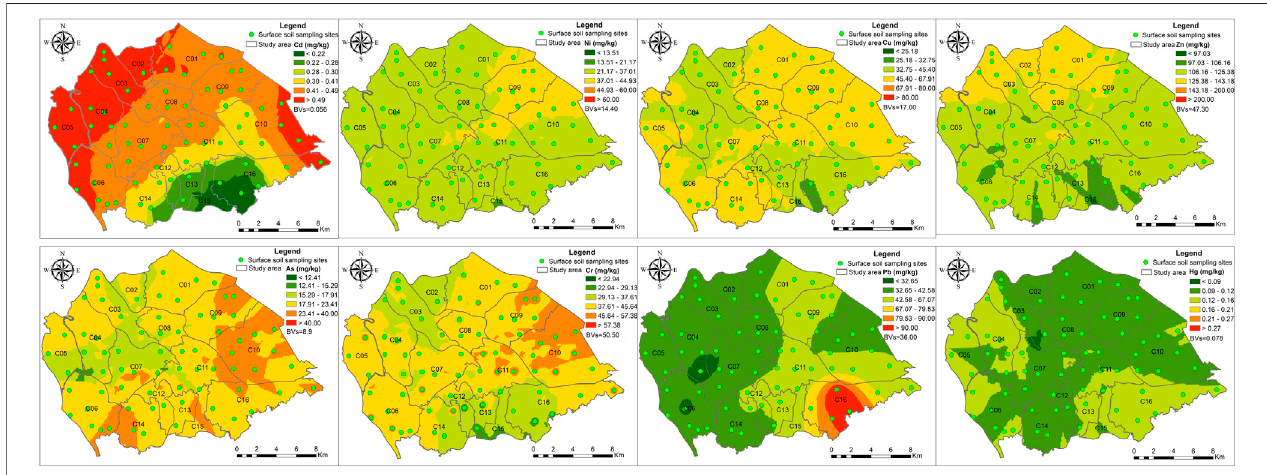
FIGURE 2 | Spatial distribution of heavy metal concentrations in surface